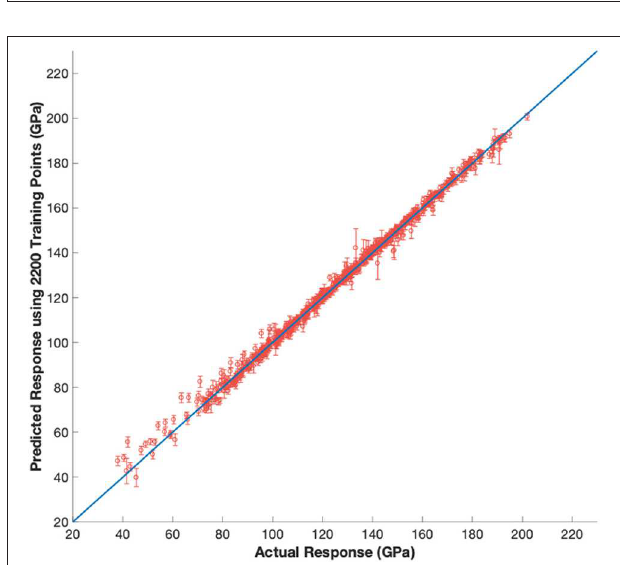
FIGURE 7 | (A) Variation in the angular change in the vector of model coefficients between model update steps. (B) Variation in the magnitude of the vector of model coefficients during the model building process.